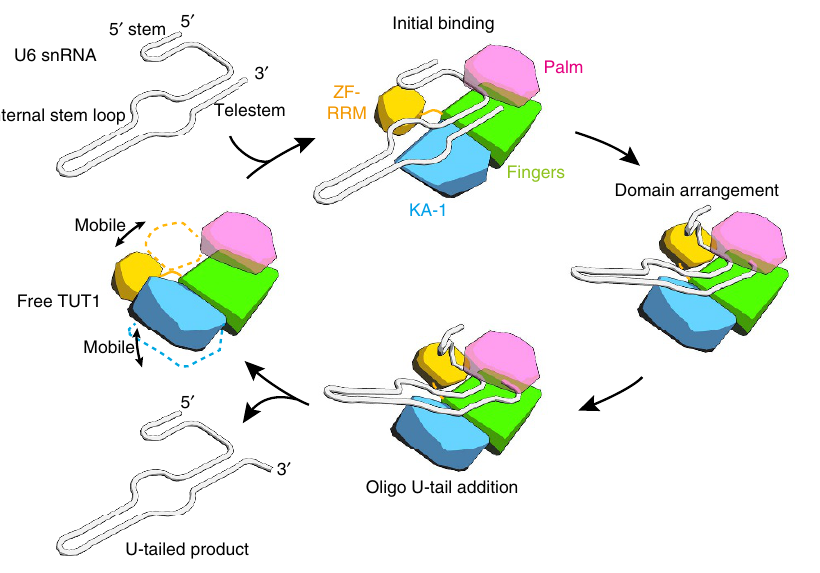
Figure 5 | Oligo-uridylylation of the 3 0 -end of U6 snRNA by TUT1. Schematic diagram of the oligo-uridylylation of the 3 0 -end of U6 snRNA by human TUT1. The N-terminal Zn-finger and RMM, palm, fingers and KA-1 domains are coloured orange, magenta, green and cyan, respectively. The Zn-finger, RMM and KA-1 are mobile, relative to the catalytic palm and fingers domains, and interact with specific regions within the U6